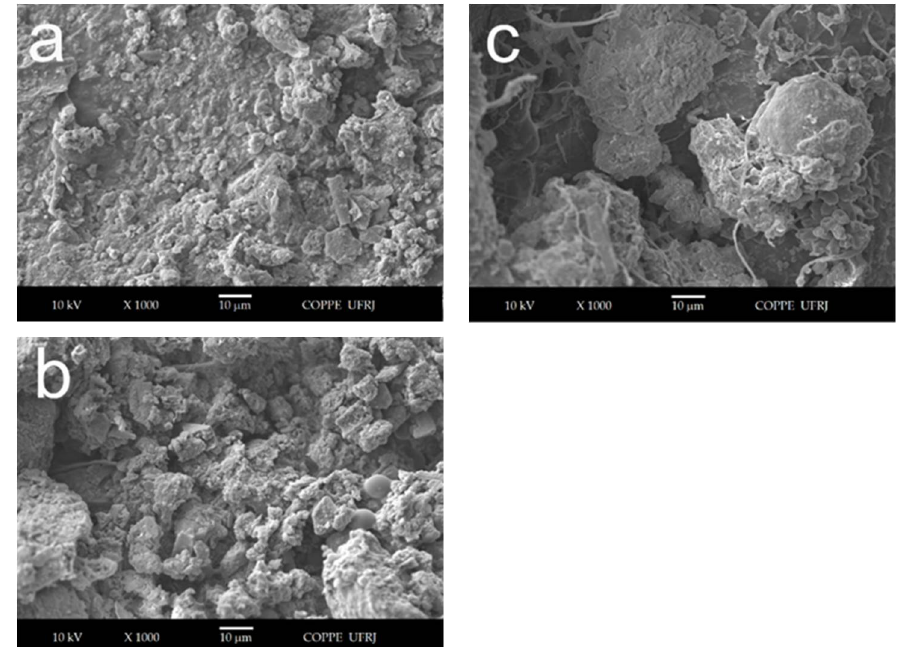
Figure 7. SEM images taken from surfaces of specimens after 90 days of incubation; TPS ( a ), TPS incorporated with GO at 1.0 ( b ) and 2.0 mass% ( c ) contents.